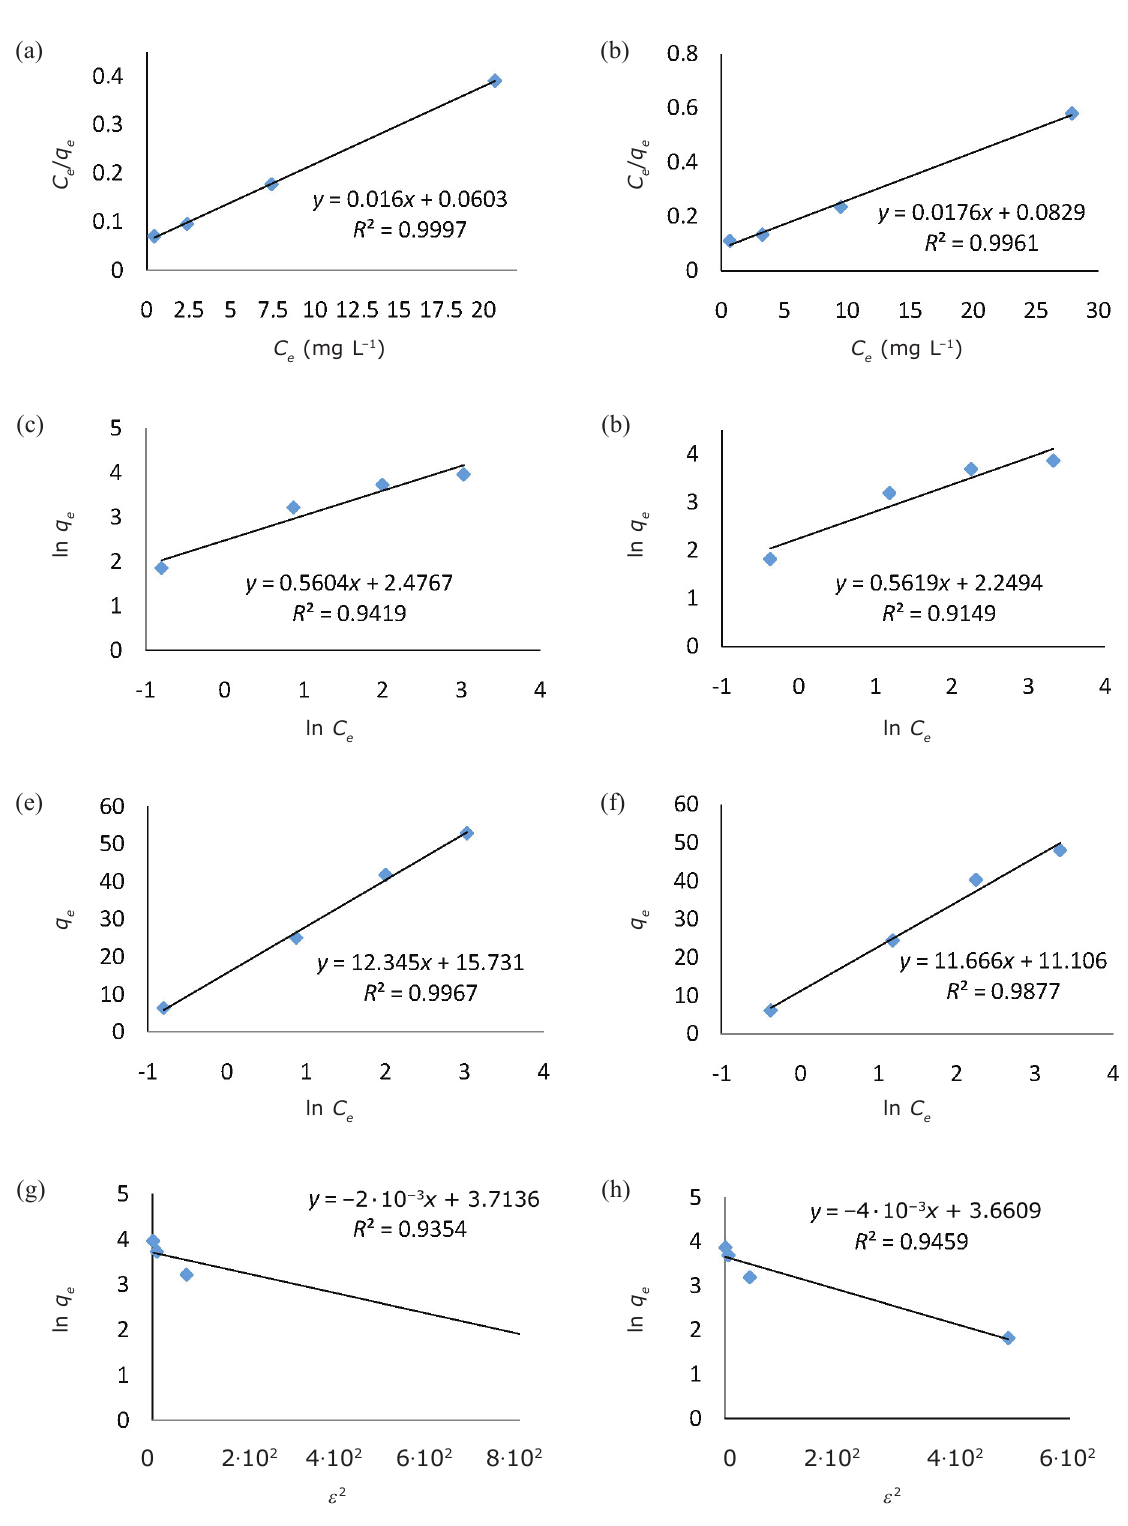
Fig. 10 – Adsorption isotherm modeling of E2 and E1 hormones on rice husk silica (adsorbent dosage of 1.5 g L –1 , pH of 4 and contact time of 60 min). Langmuir adsorption isotherm for E2 (a), Langmuir adsorption isotherm for E1 (b), Freundlich adsorption isotherm for E2 (c), Freundlich adsorption isotherm for E1 (d), Temkin adsorption isotherm for E2 (e), Temkin adsorption isotherm for E1 (f), Dubinin-Radushkevich isotherm for E2 (g), Dubinin-Radushkevich isotherm for E1